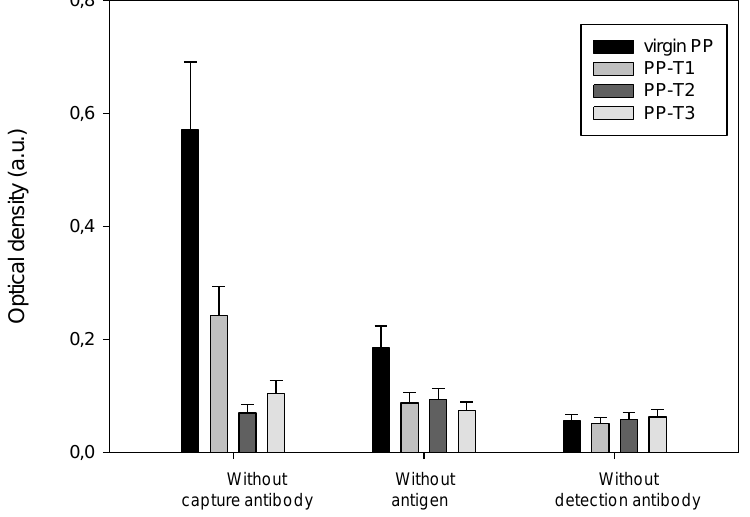
Figure 7. Evaluation of non-specific associations for each surface treatment during Pr-DVE ELISA